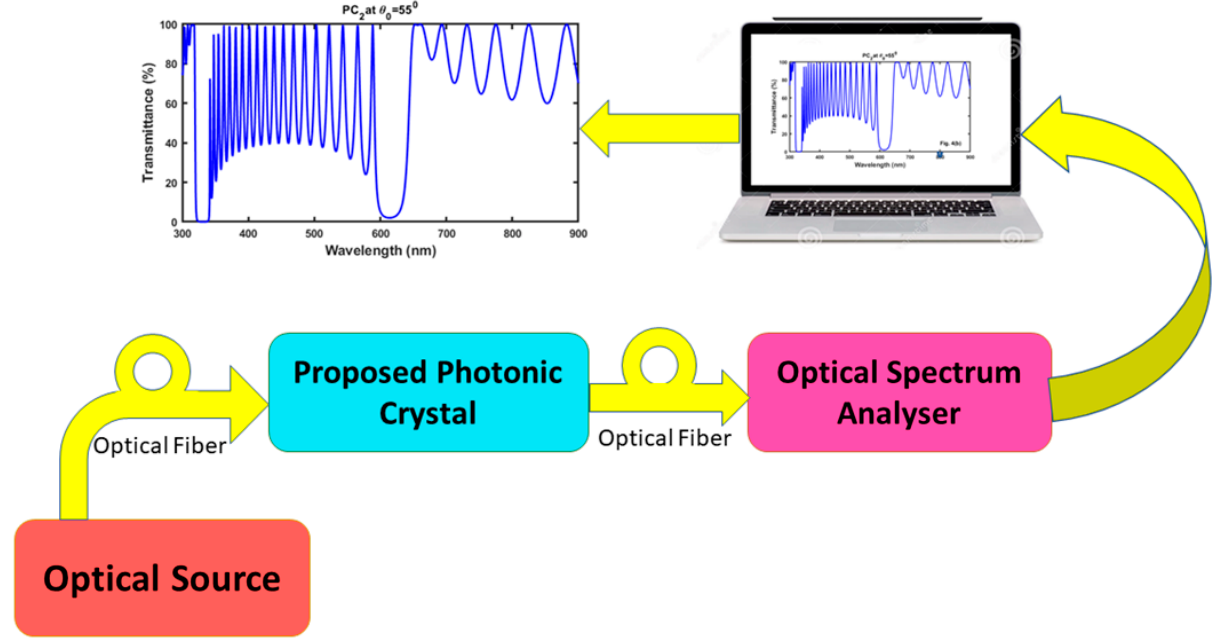
Figure 2. Systematic showing experimental setup for spectrum analysis.